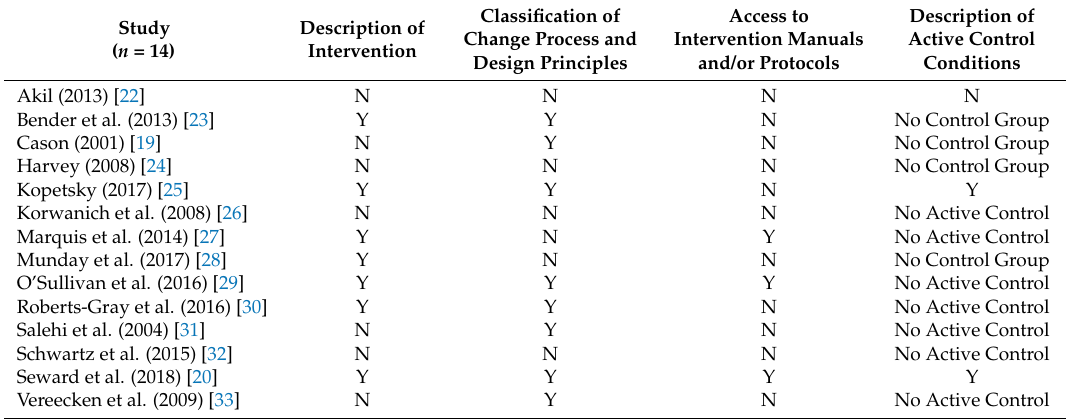
Table 5. Summary of the Workgroup for Intervention Development and Evaluation Research (WIDER)